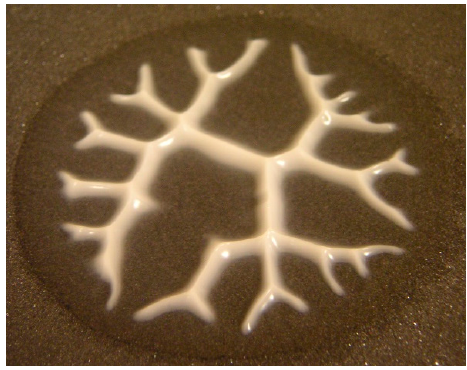
Figure 3. Fingering aspect of the remaining deposit of yield stress fluid after separation of two plates initially squeezing a thin fluid layer. (Photo Q. Barral).